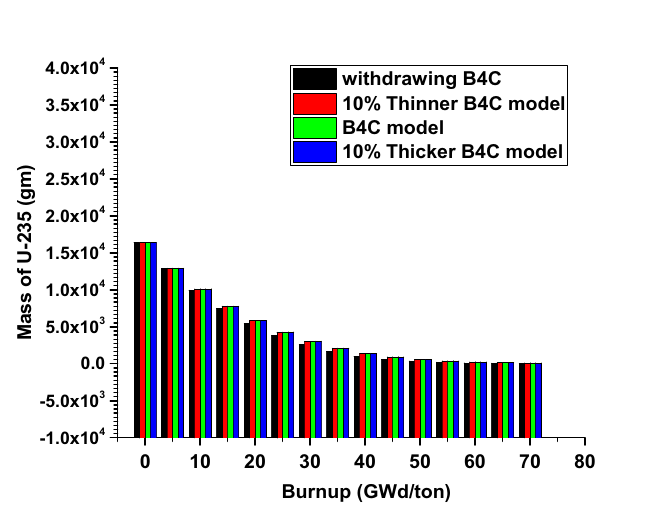
Figure 21. Mass of U-235 with burnup for the four cases.